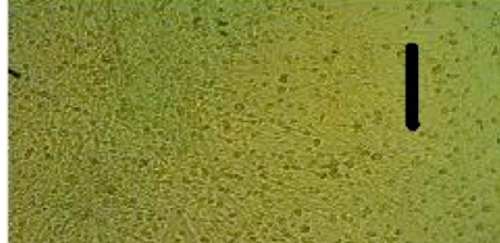
Fig. 3. Tissue culture of chicken fibroblast that